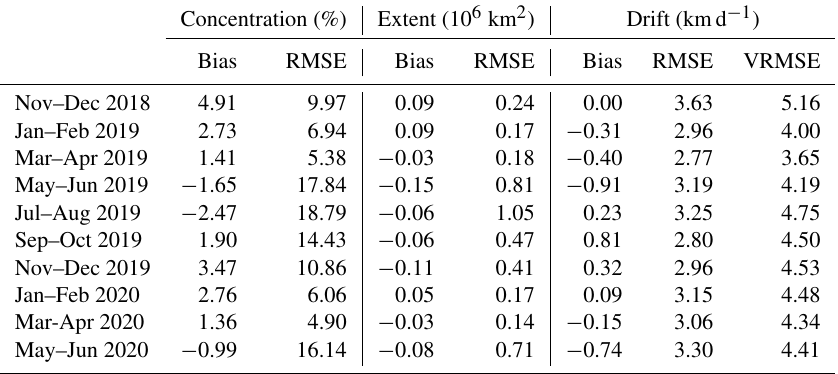
Table 1. Accuracy of the free run. Concentration and extent are evaluated against OSI SAF SSMIS; thickness is evaluated against CS2- SMOS; drift is evaluated against OSI SAF drift, where observations with reported error up to 10kmd − 1 are considered. Results are 2-